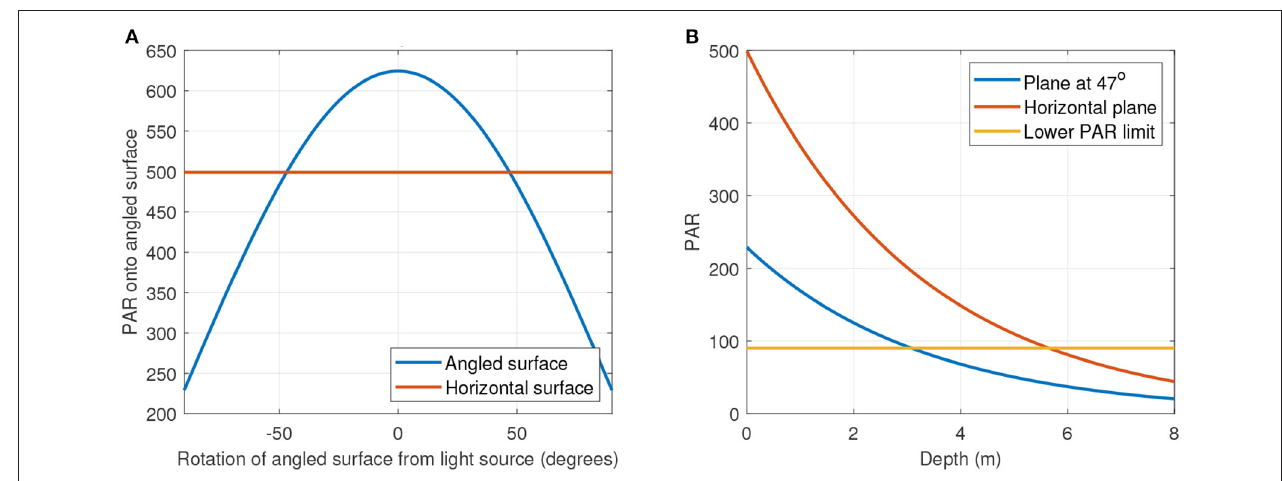
FIGURE 8 | (A) PAR ( µ mol m − 2 s − 1 ) distribution as a conical frustum plant rotates, vs. normal horizontal cultivation plant. (B) Reduction of PAR ( µ mol m − 2 s − 1 ) as a function of depth, compared to the lower PAR limit for saturation.